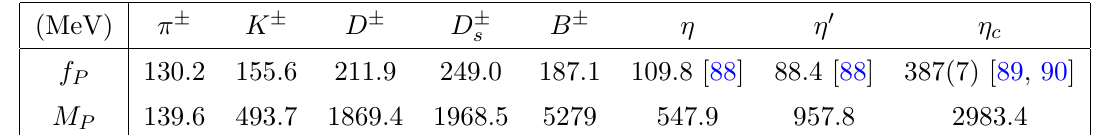
, B (cid:6) , as well as s